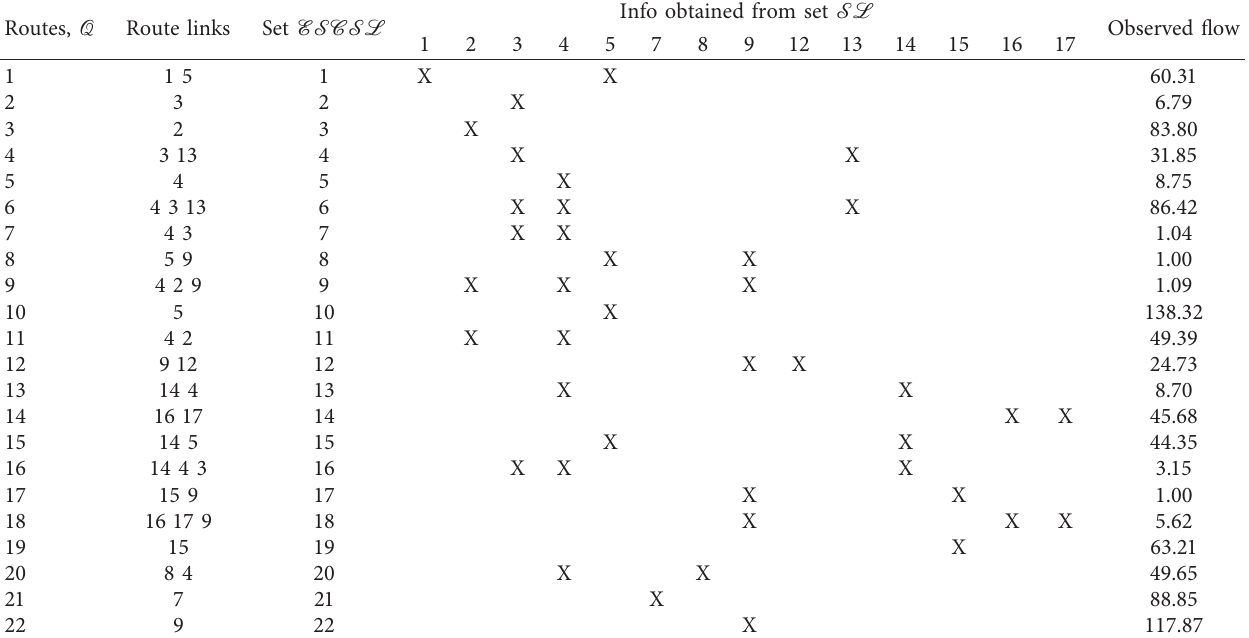
Table 1: Set of expected combinations of scanned links ( ESCSL ) associated with simplified routes in set Q and their values of observed flow. Routes, Q